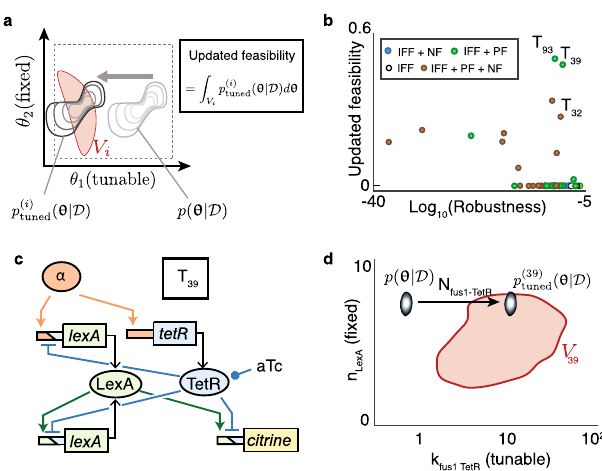
Fig. 4 Bayesian updating. a The inferred parameter posterior p( θ | D ) is compared to the viable regions V i of all topologies to calculate each topology ’ s feasibility; we shift p( θ | D ) in tunable parameter directions to p i ð θ j D Þ to maximize feasibility. b Updated ranking of topologies for the tuned short pulse decoder, highlighting promising topologies. c Circuit diagram of the best candidate, T 39 . d Projection of the viable space of T 39 , and of the parameter posterior distribution before and after tuning, on two parameters. Copy number N fus1 TetR enables tuning of promoter strength, leading to a predicted feasibility of 48% ( b ).